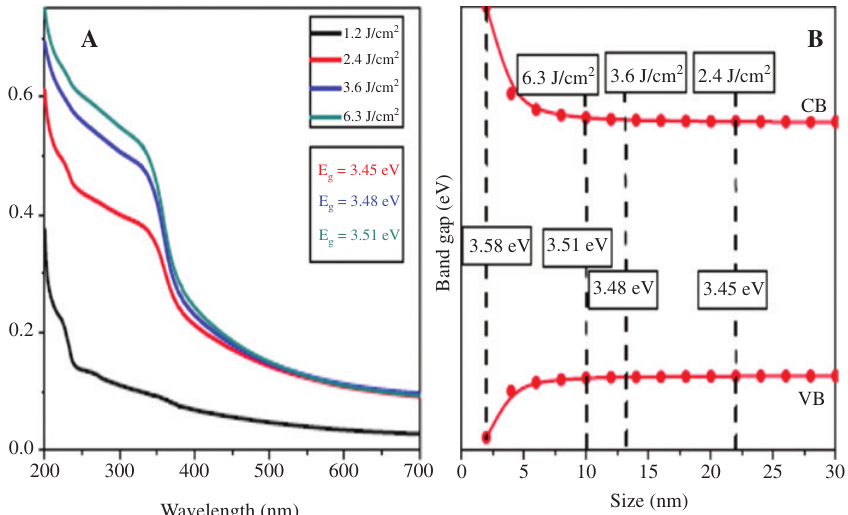
Figure 5: Variation of ZnO spectra absorbance with laser fluence wavelength and the effects of the band gaps on nanoparticle sizes. (A) Absorption spectra of ZnO obtained from laser ablation in deionized water at laser fluence 1.2, 2.4, 3.6, 6.3 J/cm 2 . (B) Band gap variation with size of ZnO nanoparticles (Reprinted with permission from Ref. [53], copyright 2017 by